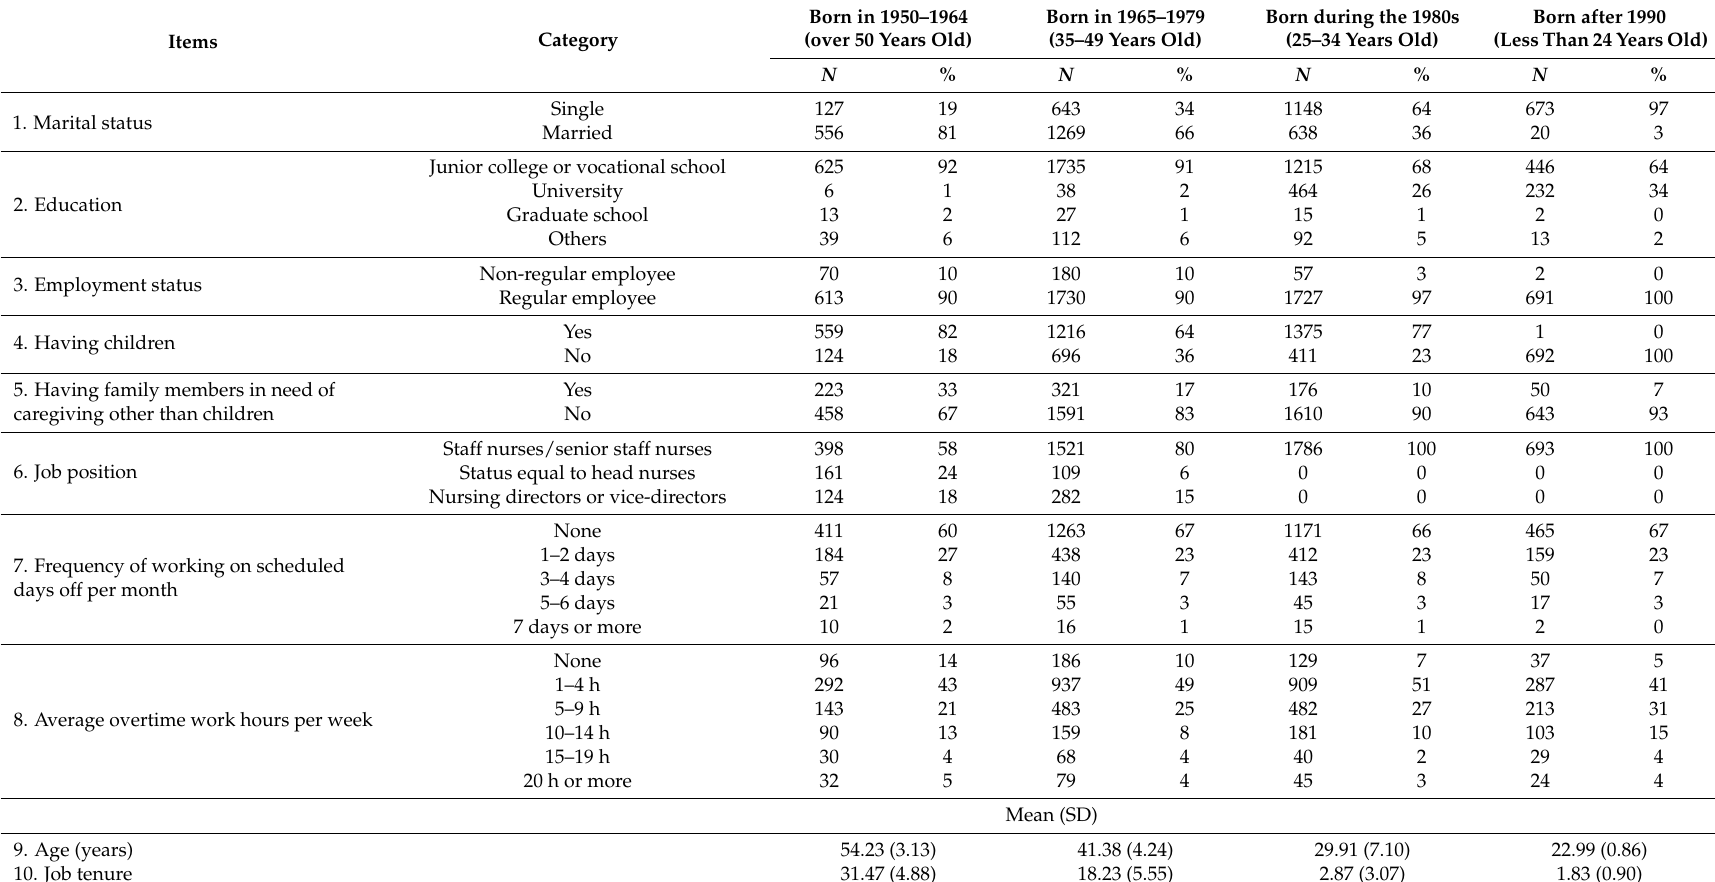
Table 1. Basic attributes of participating female hospital nurses ( N = 5108) a